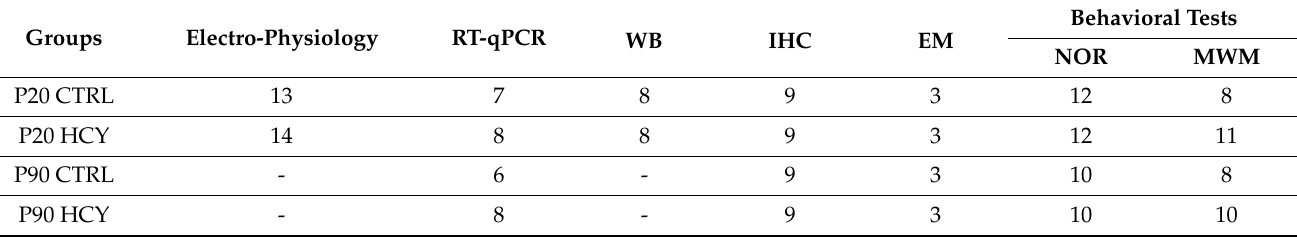
Table 1. The number of animals used in